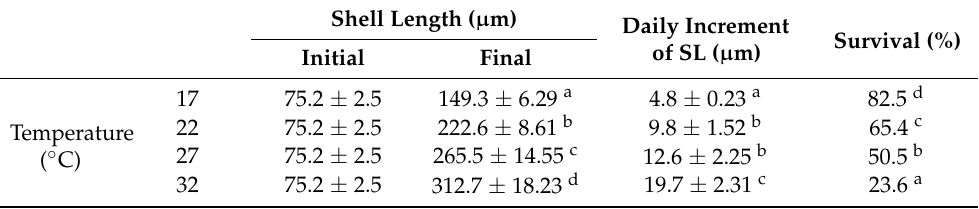
Table 1. The initial and final shell lengths, daily increment of shell length (SL), and the survival rate of Mactra chinensis reared at different water temperatures for 15 days.